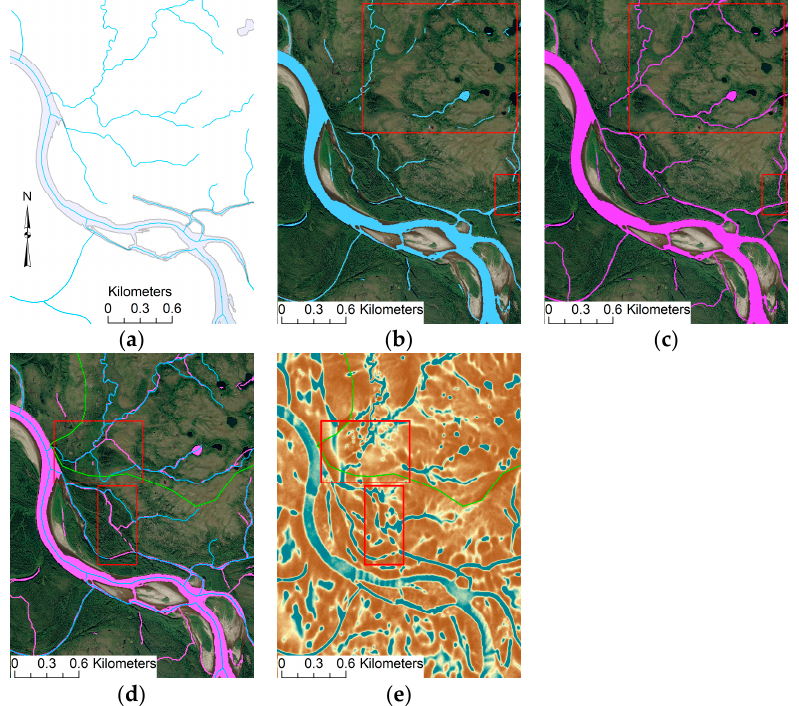
Figure 18. Comparison of ( a ) reference hydrography with ( b ) U-net model 14 predictions ( c ) U-net model 14 predictions augmented with flow network extracted with the D-8 flow accumulation model weighted with model 14 probabilities, ( d ) augmented model 14 predictions with reference flowline network, and ( e ) 2-D shallow water depth model with deep channels in darker blues and higher terrain in darker browns. Red boxes highlight areas for discussion, and the green line in d and e is a watershed